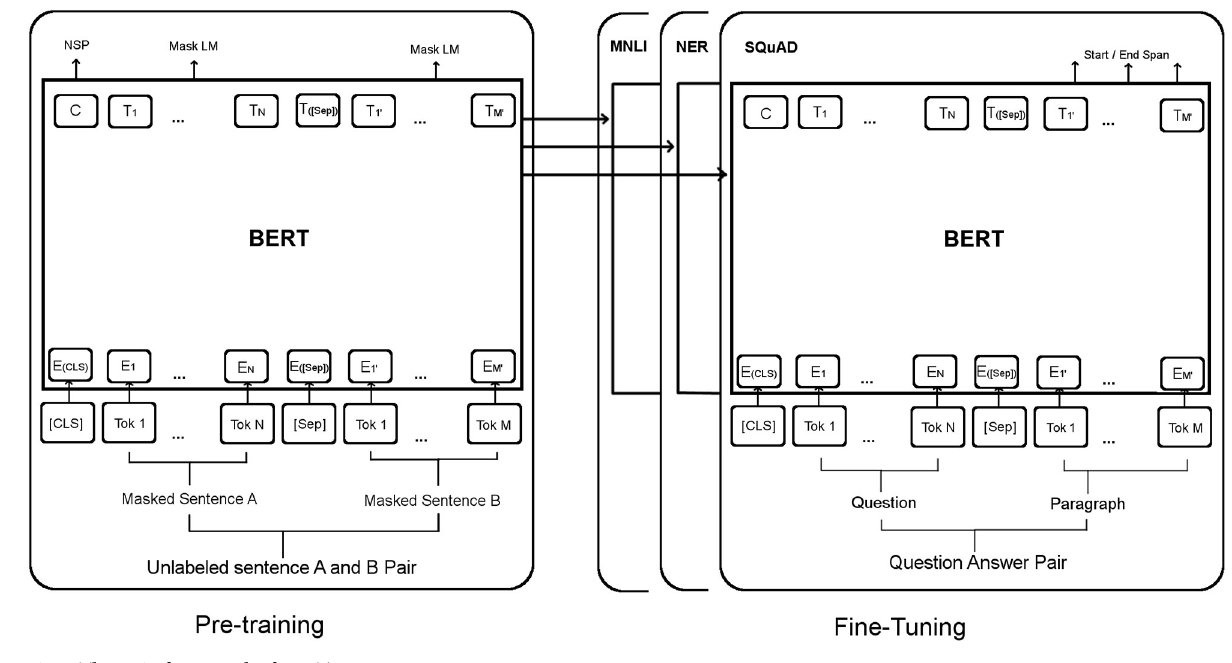
Fig 1. The main framework of